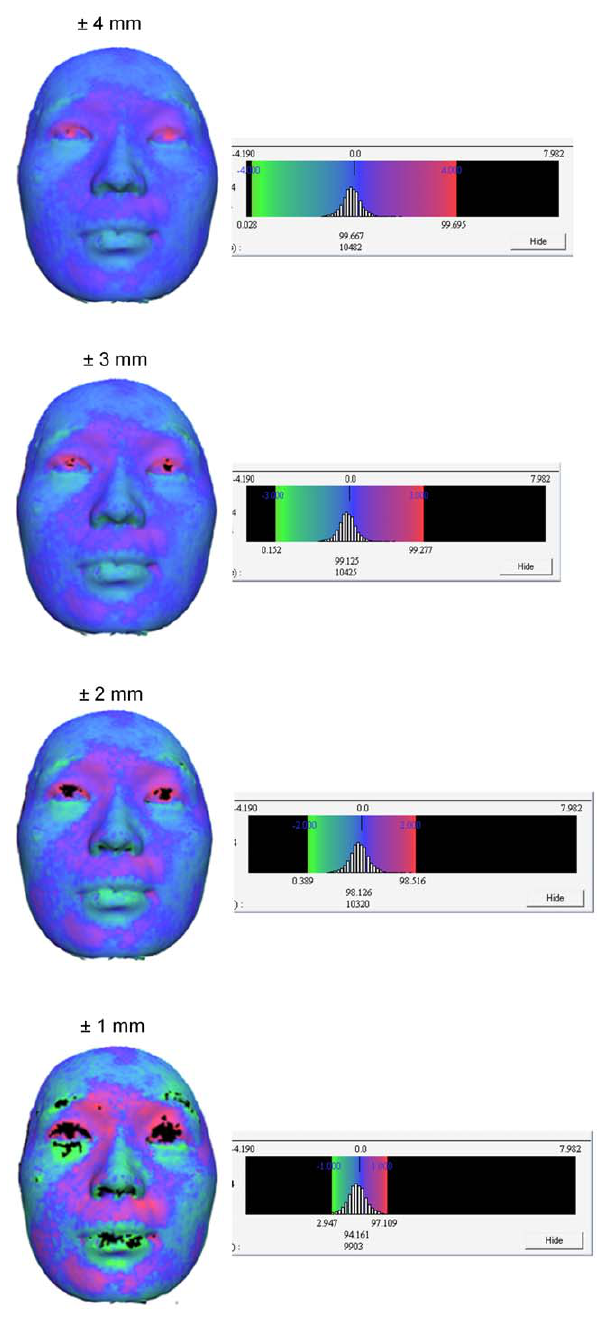
Figure 7. Colour maps and the accompanying histogram. The 6 sign depicts the distance range of the histogram.